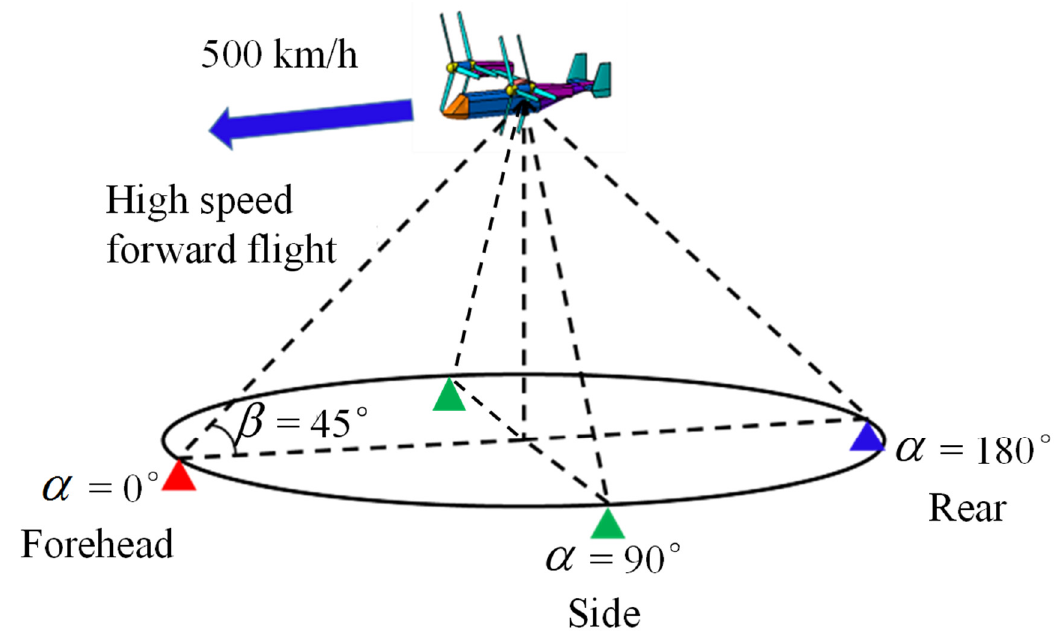
Figure 9. Schematic diagram of simulation in fixed-wing mode.